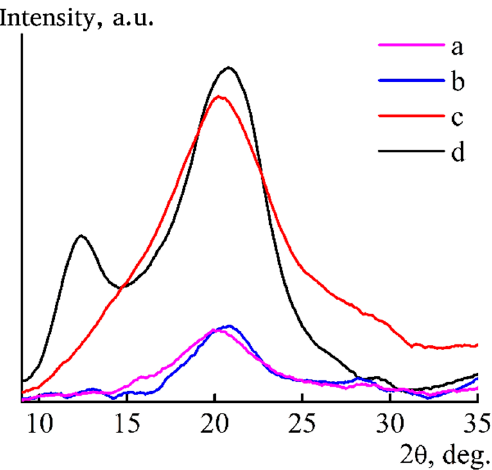
Figure 11. X-ray diffractograms of cellulose films formed in IPA (T = 25 °C) and then aged in alcohol (a,c) or water (b,d) and dried at room conditions in transmission (a,b) and reflection (c,d) modes. The diffractogram of regenerated cellulose II is characterized by the presence of maxima with angular positions 2 θ ~12.3°, ~20.5° and ~21.9° [42]. The diffractogram of the film sustained in water